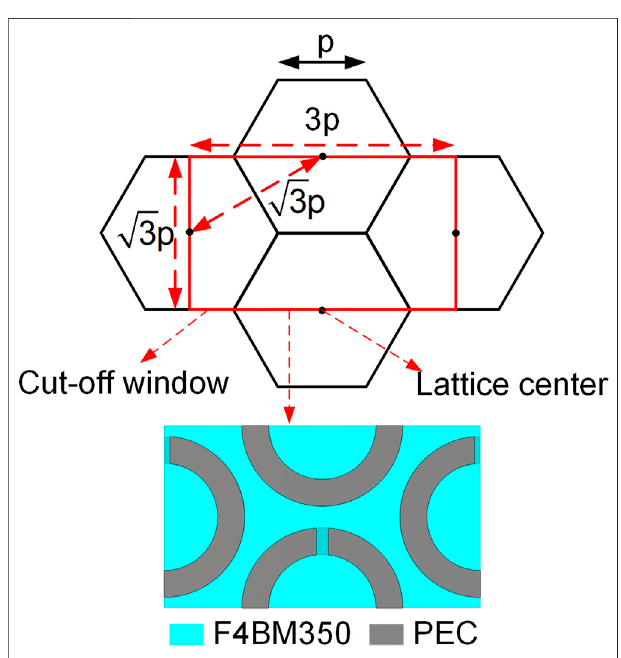
FIGURE3| Thetopviewofthesimulationmodelofunitcellsinauniform hexagonal lattice.